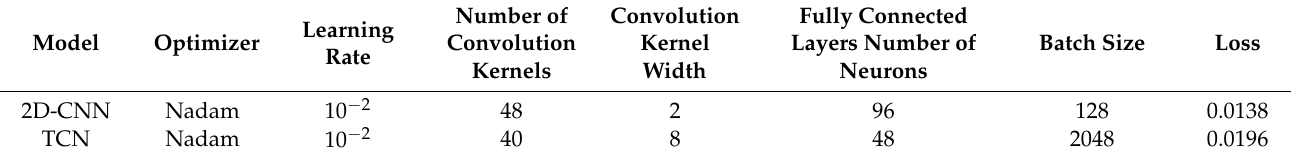
Figure 8. Parallel coordinate plots corresponding to the four parameter configurations and target values for BOHB search in the 2D-CNN model. Table 5. Optimal parameter values of multi-nuclide source term inversion model based on 2D-CNN and TCN.